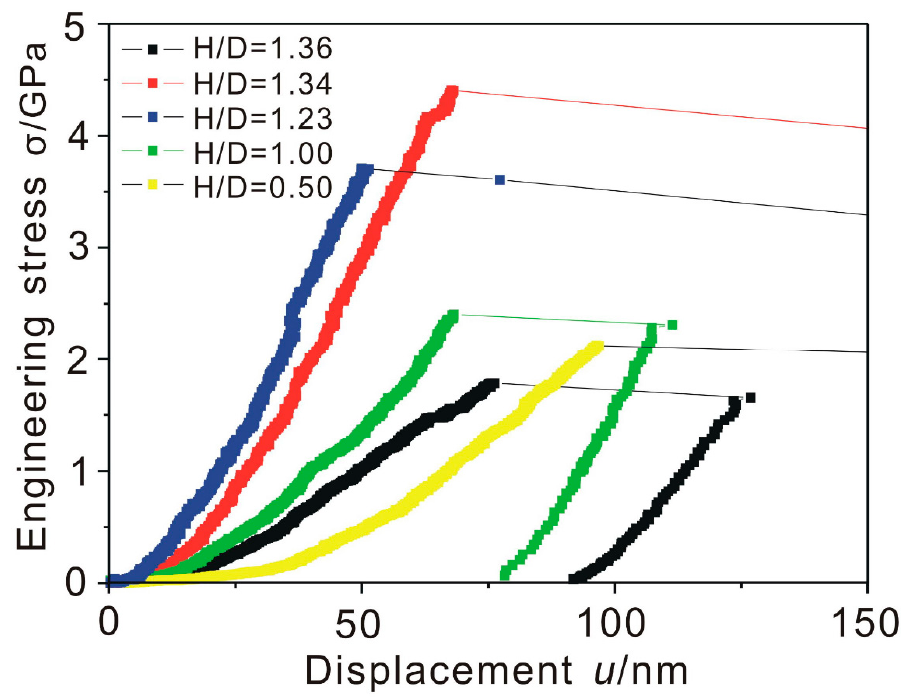
ff erent aspect